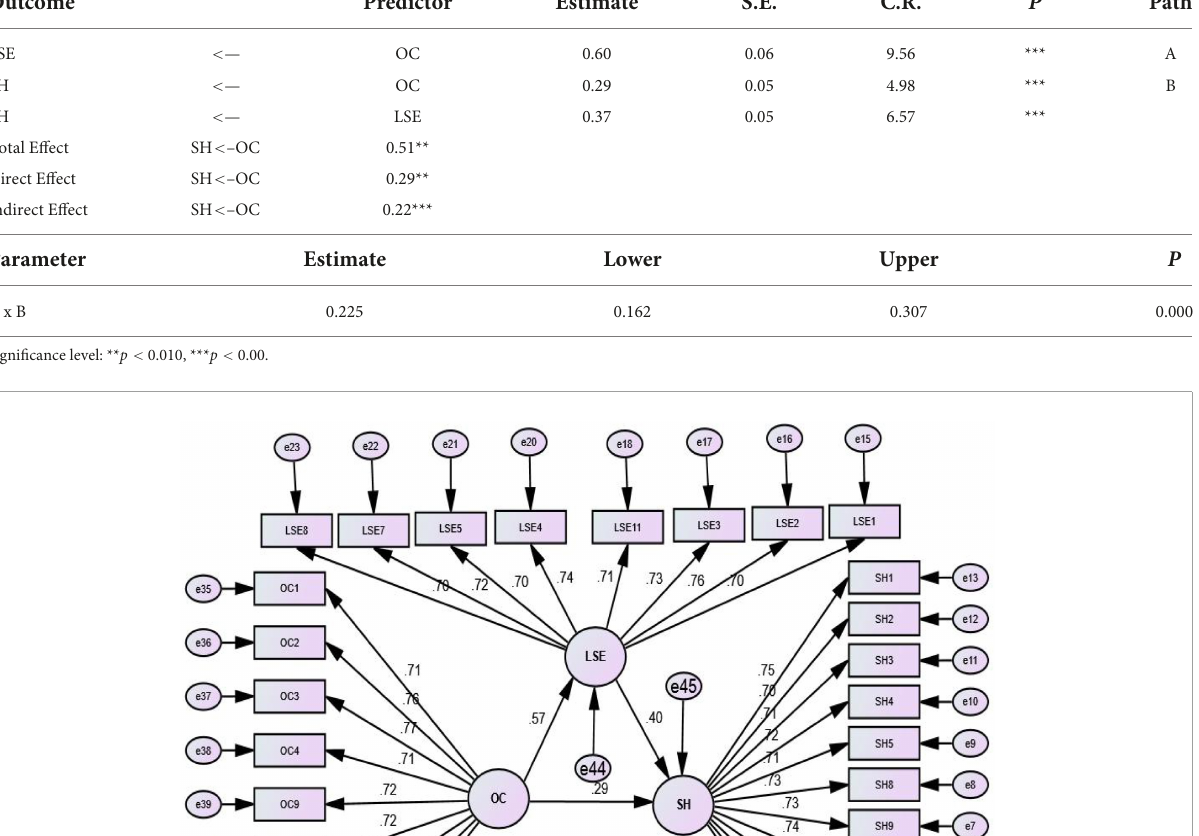
structure on LSE ( Figure 4 ). Hence, all the hypotheses were